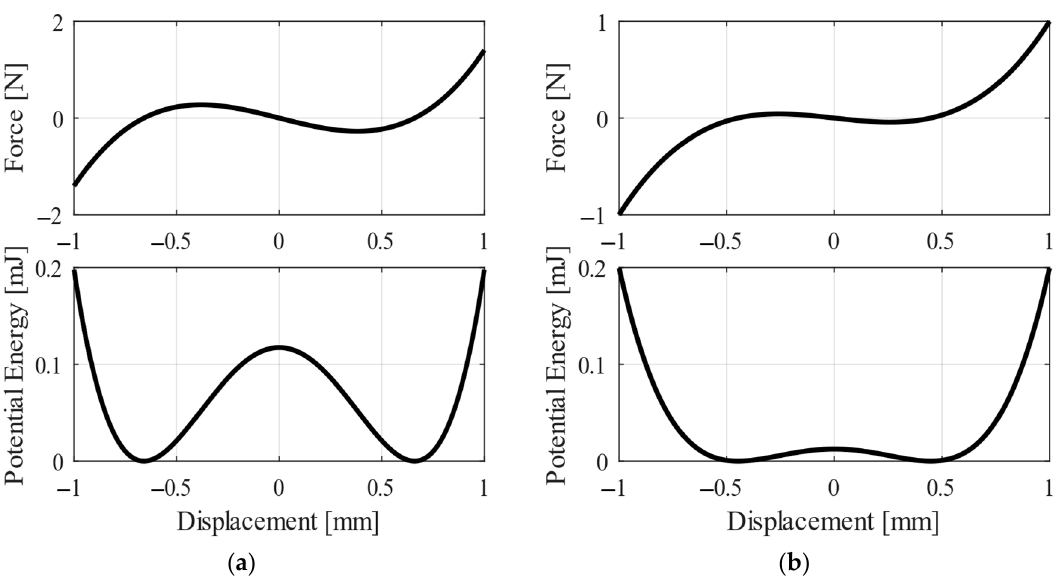
Figure 9. The magnetic force and potential energy in bistable oscillator with ( a ) huge barrier and ( b ) low barrier between two stable positions.